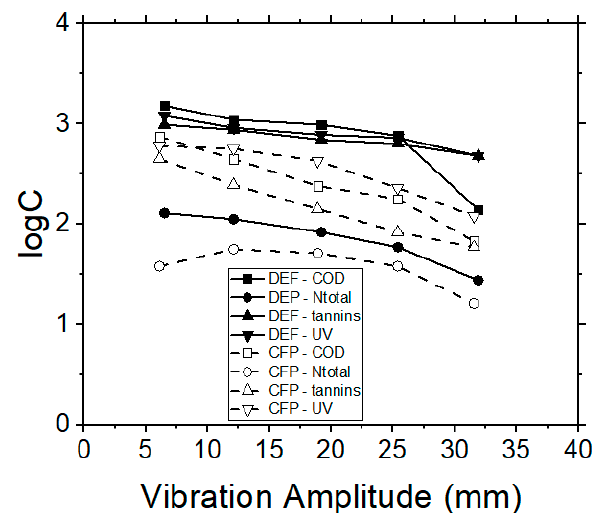
Figure 8. VSEP treatment of simulated tannery wastewaters; effect of vibration amplitude on COD, N total , UV 254 nm (NOM) and tannins concentrations, when performing RO membrane experiments, during dead-end (DEP) or cross-flow (CFP) operational modes.